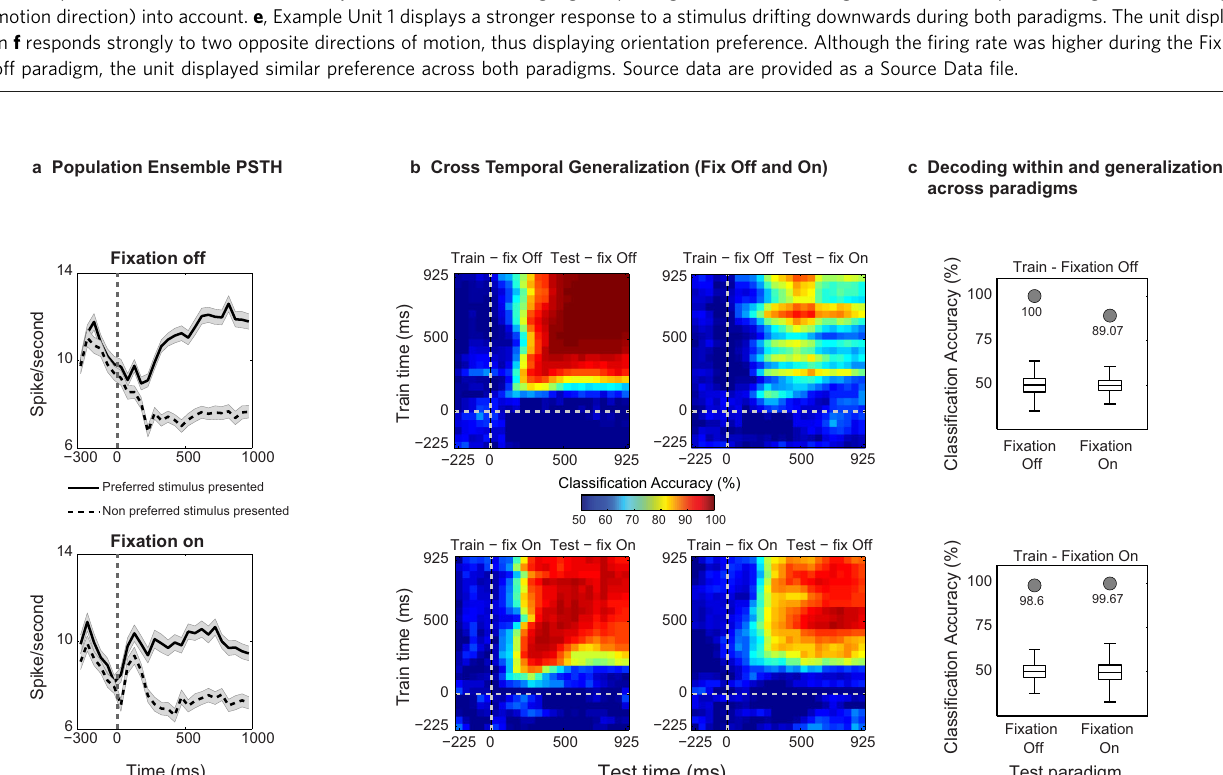
Fig. 6 Control paradigms - Fixation Off, Fixation On and example unit activity. Trials started with a fi xation spot, cueing the animal to bring and maintain gaze within a fi xation window (300 ms), following which a drifting stimulus was presented monocularly. a , During Fixation Off, the fi xation spot was removed at stimulus onset, thus inducing OKN. b , During Fixation On, the stimulus was presented without removal of the fi xation spot, and the animal was required to maintain its gaze within a window (±1 or ±2°) until the trial ended, to receive a juice reward. c , During each trial, a stimulus drifting in one of eight different directions (pseudorandomized across trials) was presented. d , Whisker box plots (for box plot description, see statistical information, methods) displaying the distribution of standard deviations (STD) estimated from the eye movement signal (y-coordinate) elicited on individual trials during stimulus presentation (0 – 1000 ms). For Fixation On, either all ( n = 187) or selected trials ( n = 95), which displayed lower variance in the eye movement (E.M.) signal were analyzed (see methods). The STD was signi fi cantly reduced (Wilcoxon rank-sum test, two-sided, *** denotes p ≤ 0.001,